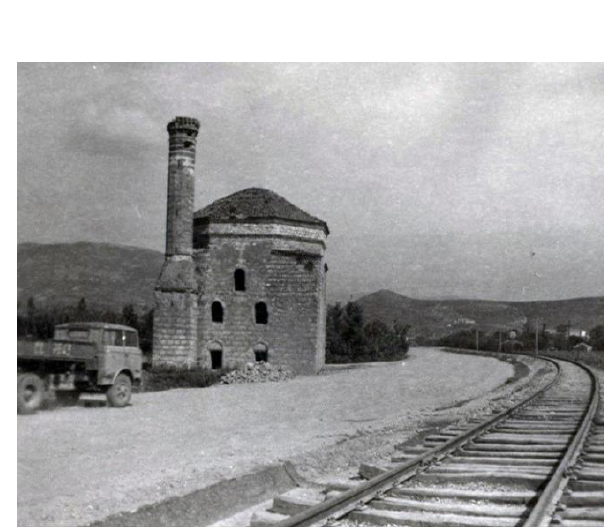
Figure 3. Motorway and rail way built next to structure 1950s, (ob- tained from Albanian National